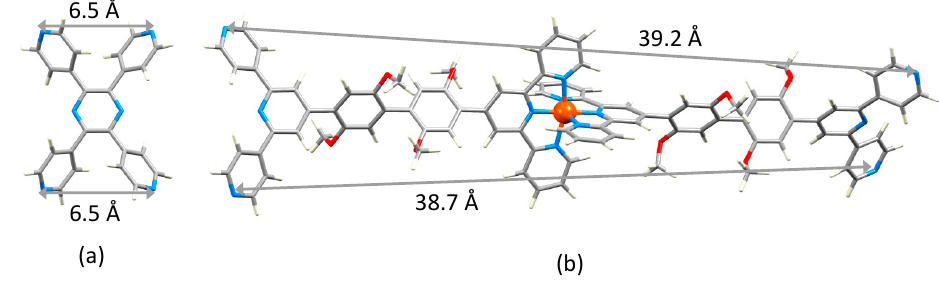
Figure 9. Modelled structures of ( a ) tetra(pyridin-4-yl)pyrazine and ( b ) [Fe( 6 ) 2 ] 2+ .